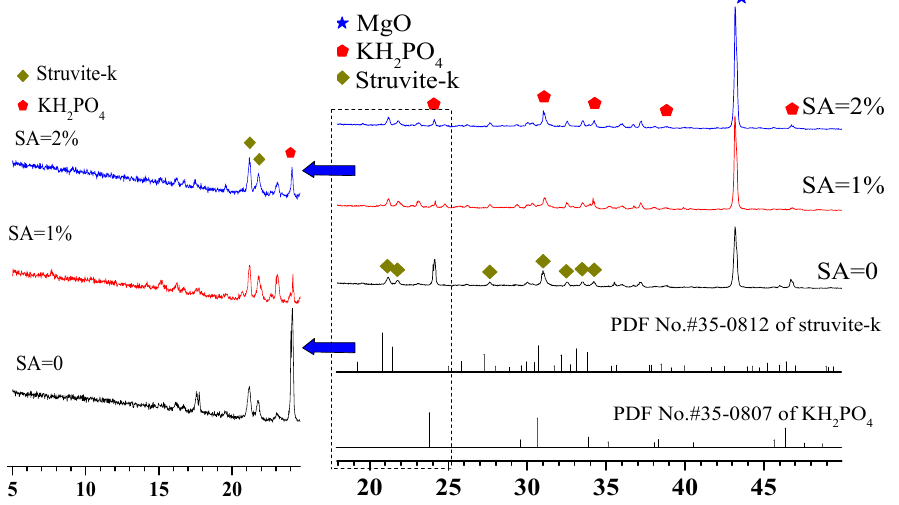
Figure 6. XRD diffraction patterns of MKPC at a w/c ratio of 0.2 after 3 h of